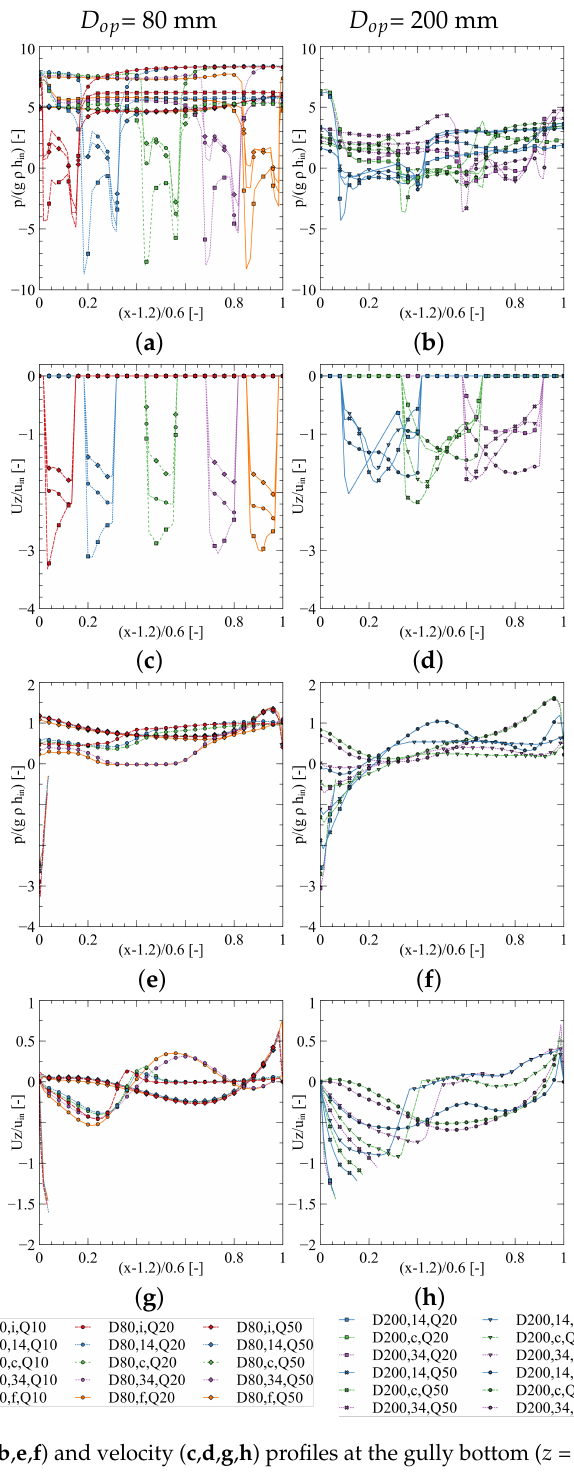
Figure 3. Pressure ( a , b , e , f ) and velocity ( c , d , g , h ) profiles at the gully bottom ( z = 0.3 m)—( a – d ) and top ( z = 0.6)—( e – h ) for D = 80 mm ( a , c , e , g ) and D = 200 mm ( b , d , f , h